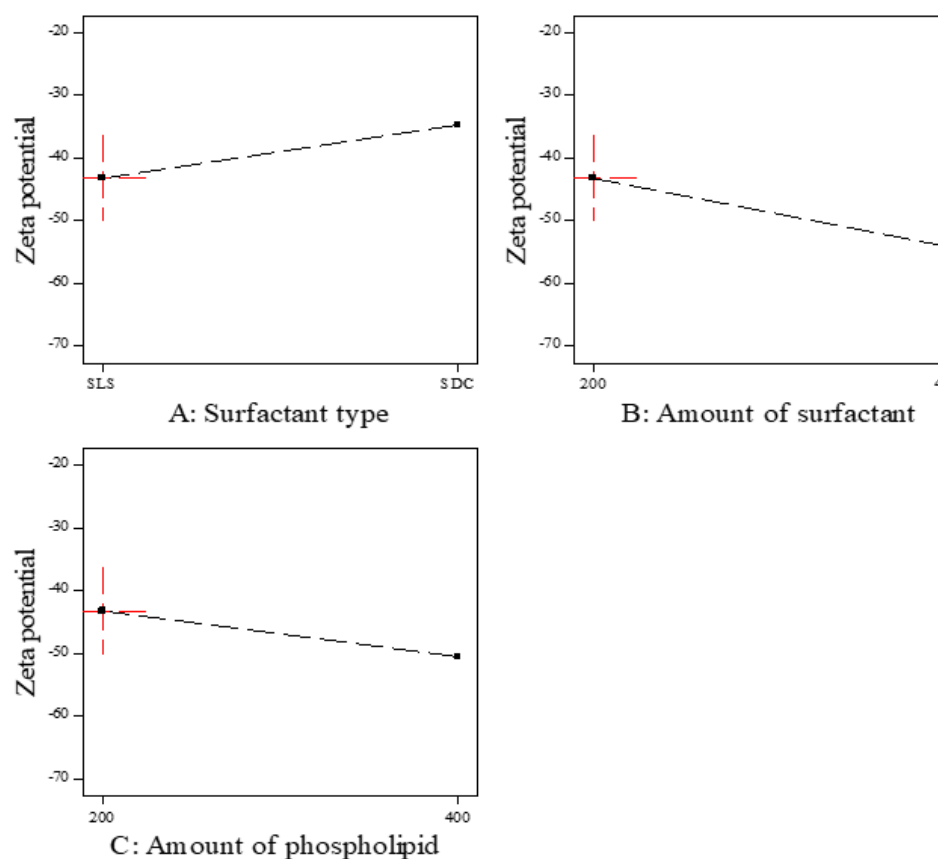
Figure 3. The effect of formulation factors on the Zeta potential (Y3).